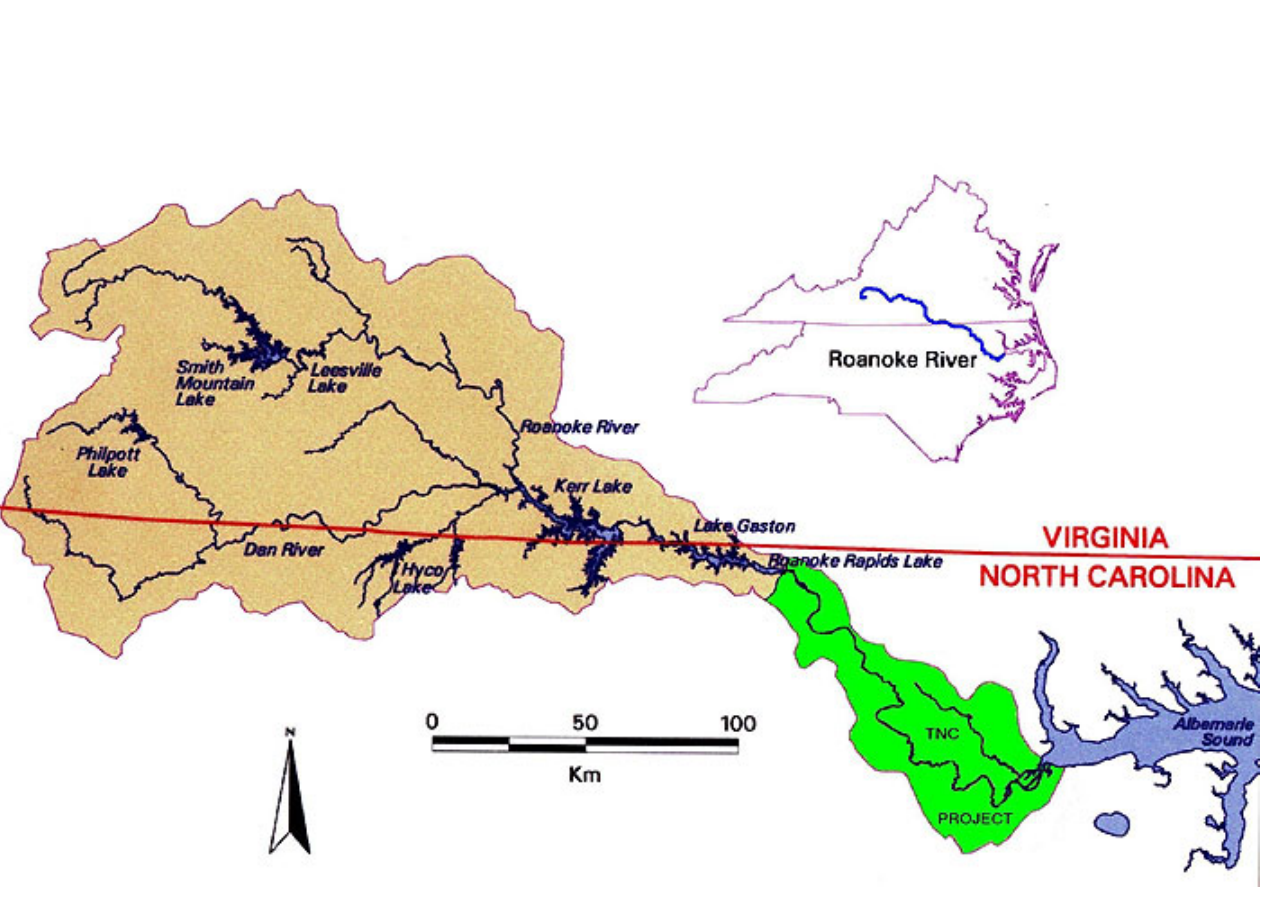
Fig. 1 . Roanoke River